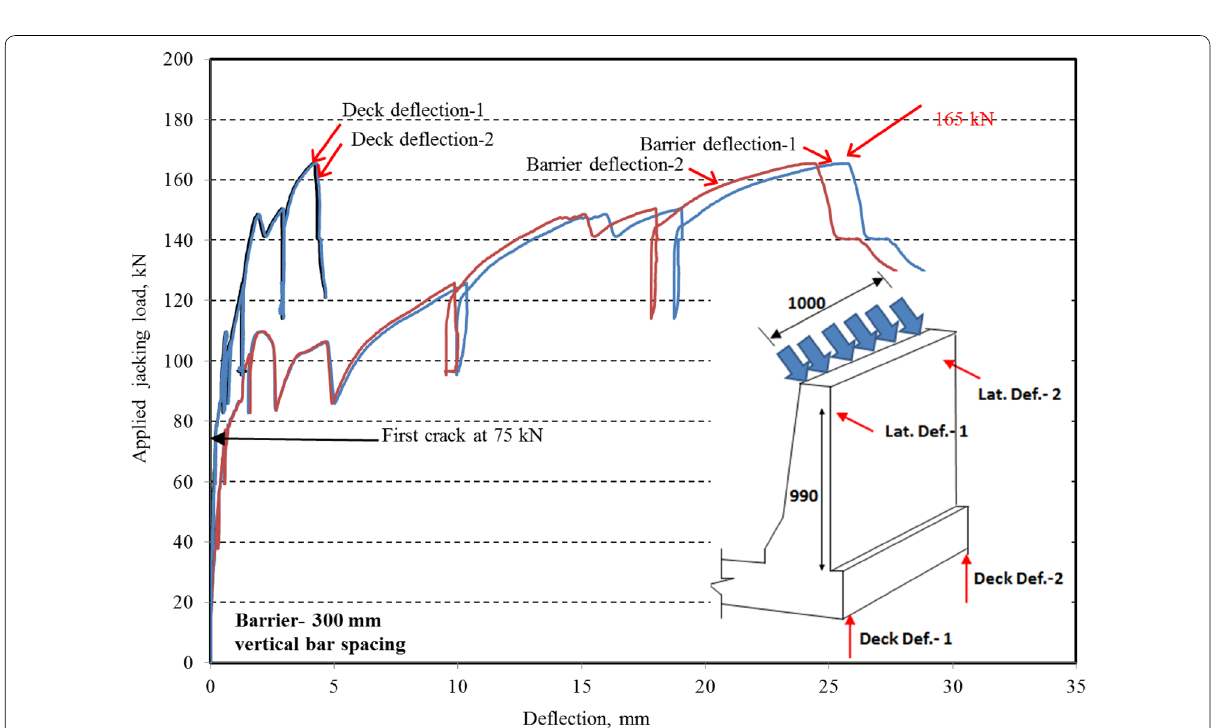
Fig. 17 Load-deflection relationship of the 1-m barrier wall at interior